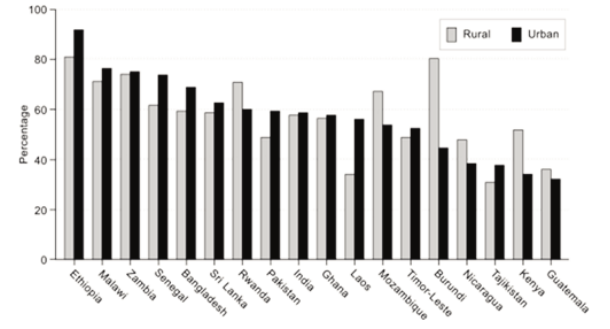
Fig. 1 - Rural and urban index of food energy. International Food Policy Re se arch Institute (IFP